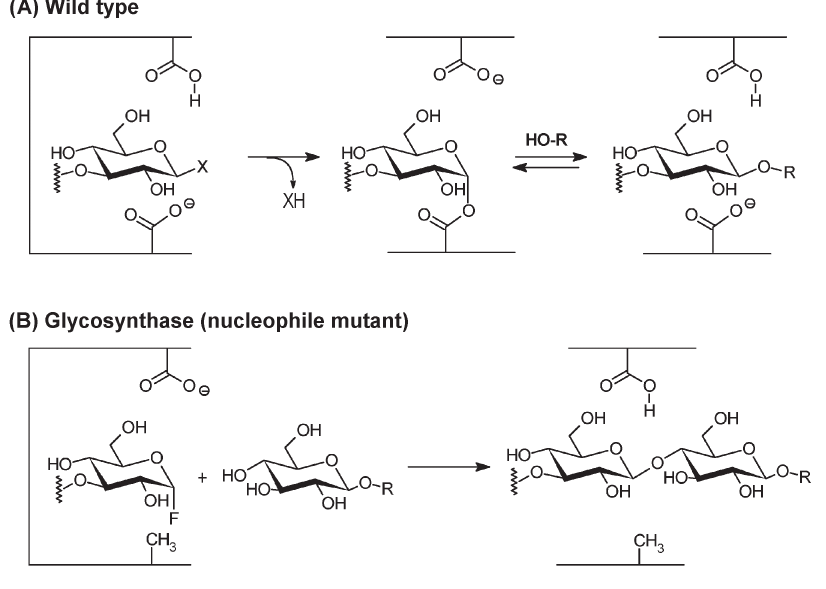
Figure 1. Transglycosylation and glycosynthase reactions catalyzed by retaining glycosidases. (A) Trans- glycosylation or hydrolysis (R = hydrogen) catalyzed by a wild-type glycosidase. (B) Glycosynthase reac- tion catalyzed by a nucleophile mutant